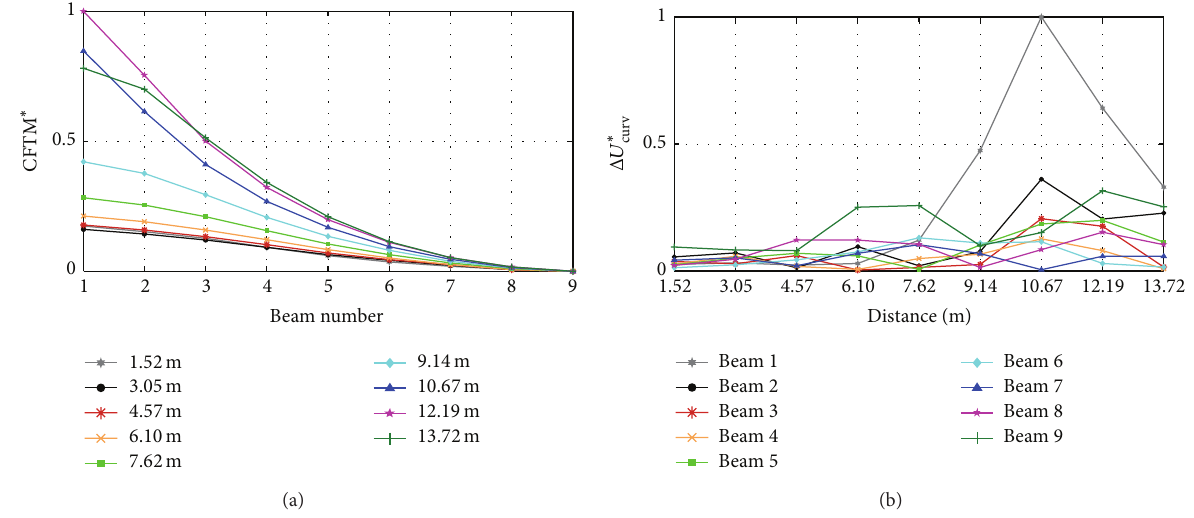
Figure 8: Plot of (a) CFTM ∗ and (b) Δ𝑈 ∗